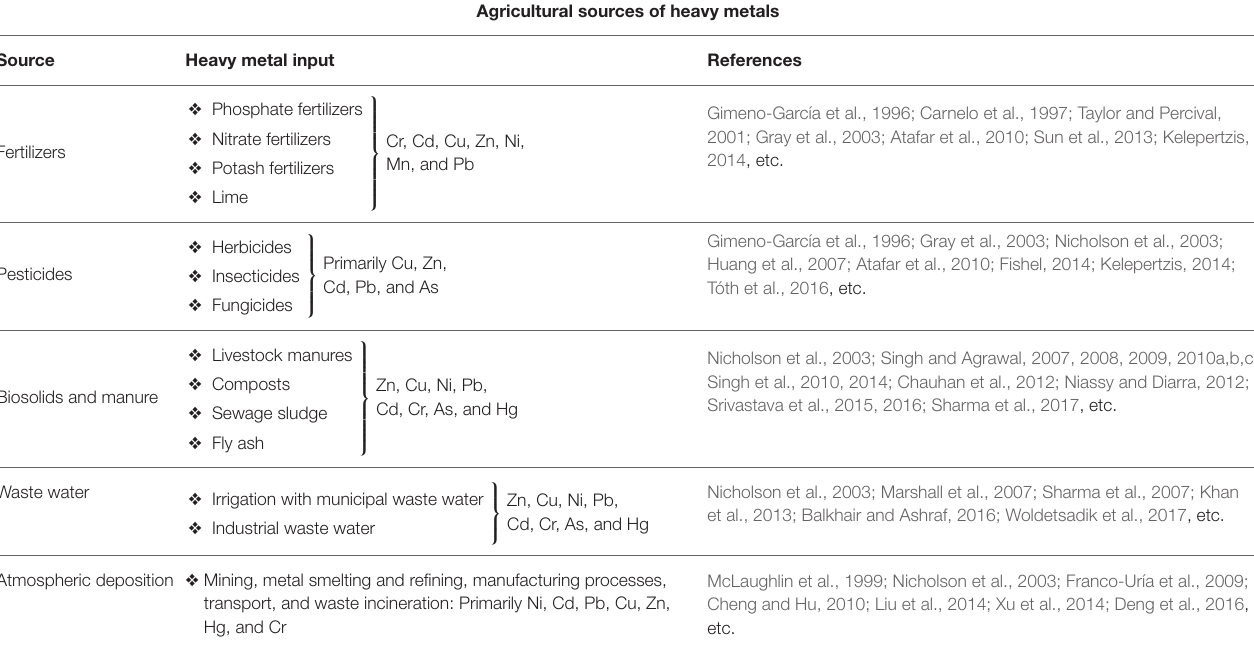
TABLE 1 | Sources of heavy metals in agricultural